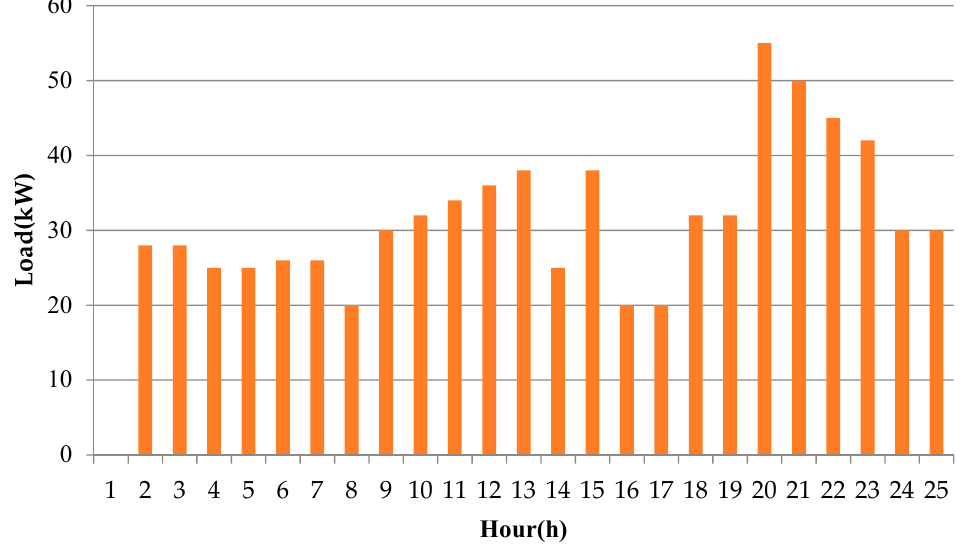
Figure 3. Daily load profile for each hour of the day.